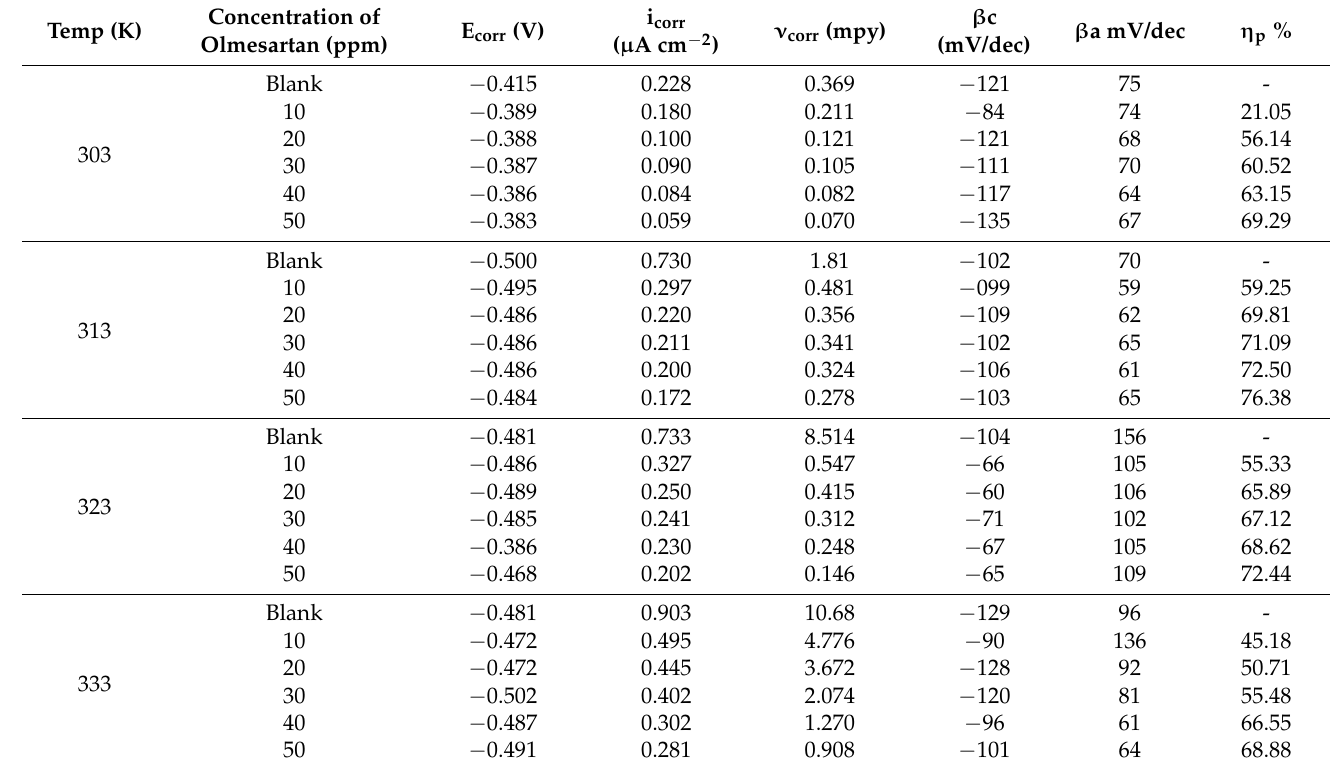
Table 3. The corrosion parameters by potentiodynamic polarization